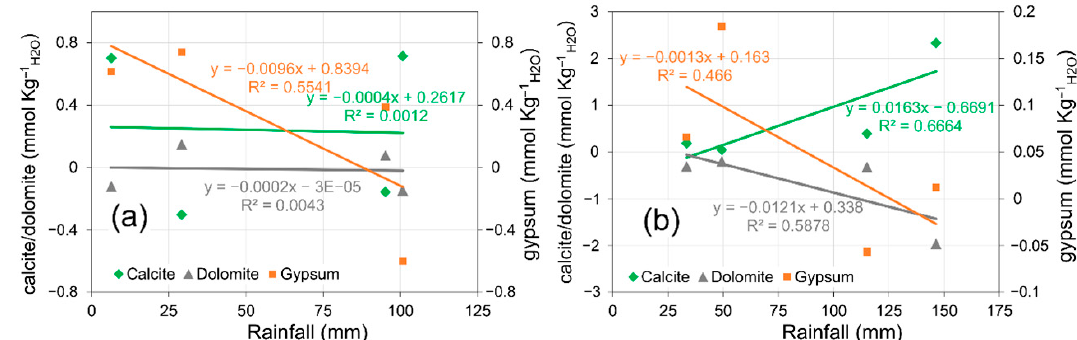
Figure 9. Relation of the potential precipitation/dissolution rates for calcite, dolomite, and gypsum with average the accu-